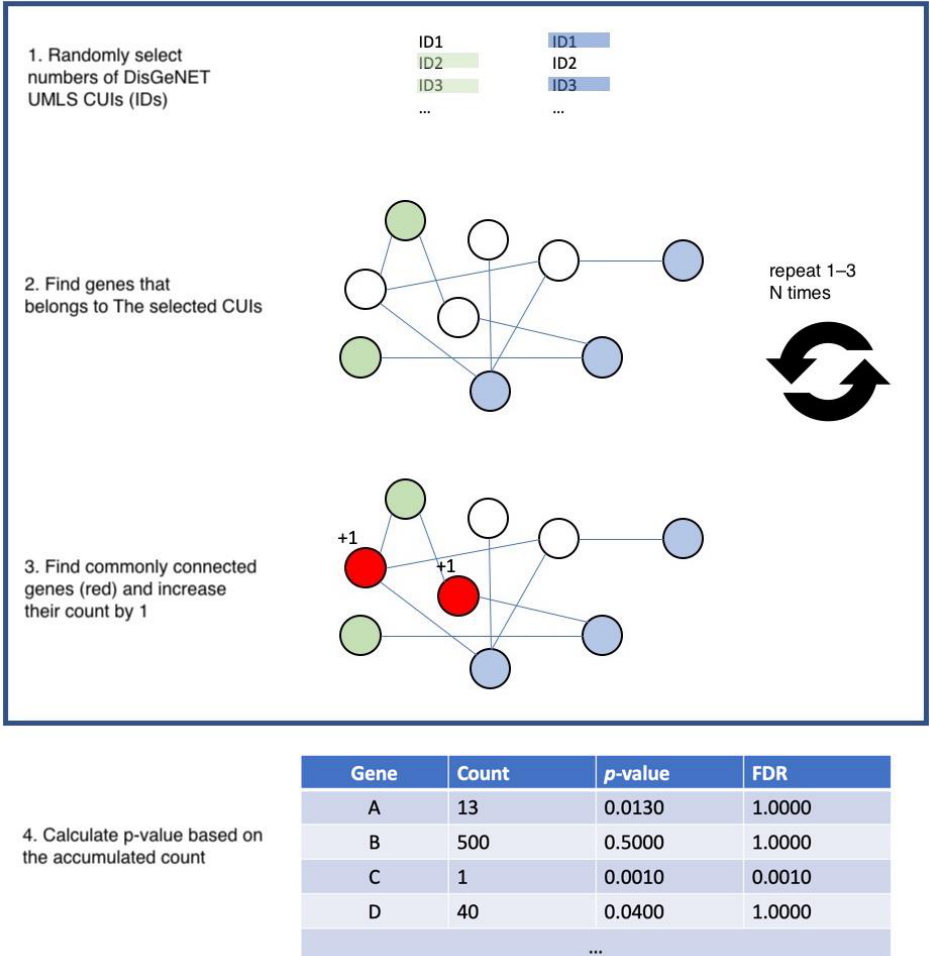
Figure 3. This figure demonstrates the permutation analysis used to identify common driver genes. For a given gene set of interest, this is randomly checked against a list of random genes. This sequence is run repeatedly and corrected to remove overlap and to test the strength of association between genes associated with both diseases. FDR: False Discovery Rate.